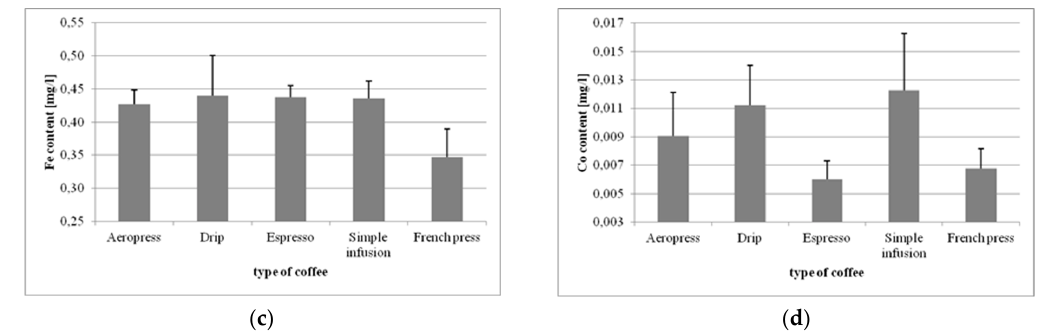
Figure 2. Concentrations of Zn ( a ), Cu ( b ), Fe ( c ), and Co ( d ) in coffee beverages made using different methods.